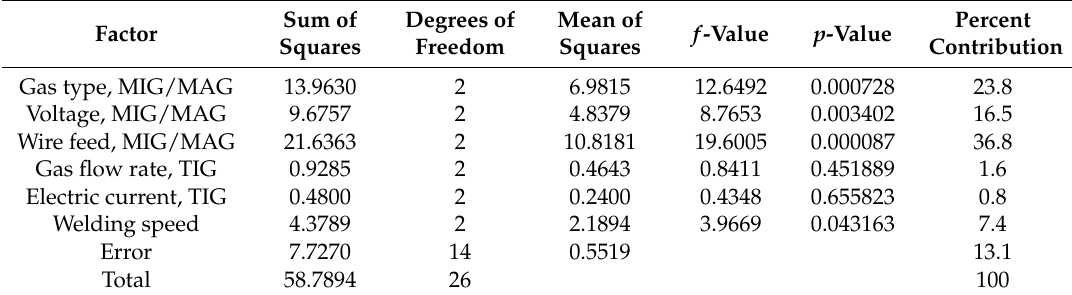
Table 3. Analysis of variance for the penetration of the